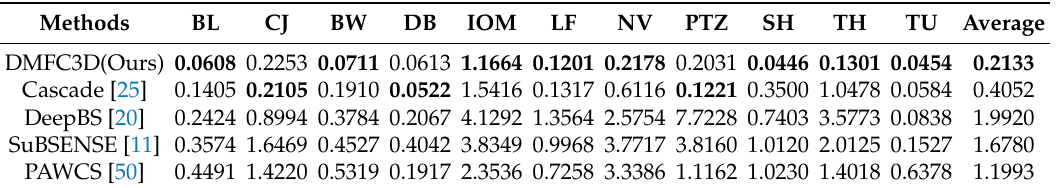
Table 2. PWC (%) comparison of different foreground detection methods over all categories of the CDnet2014: baseline (BL), cameraJitter (CJ), badWeather (BW), dynamicBackgournd (DB), intermittentObjectMotion (IOM), lowFramerate (LF), nightVideo (NV), PTZ, shadow (SH), thermal (TH), and turbulence